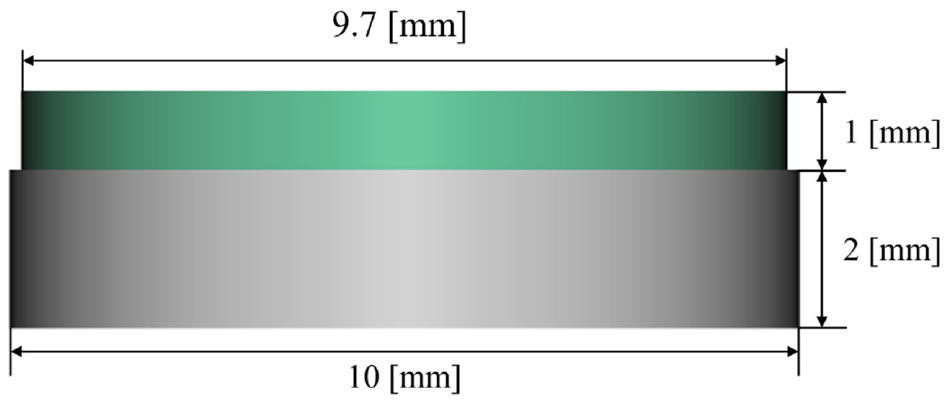
Figure 2. Geometrical dimension of samples (back view): grey cylinder- base of the samples, green cylinder- design space.